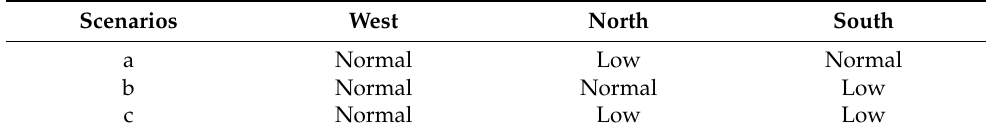
Figure 1. The divided three zones of IEEE 39 Bus New England power system. Here in the Figure, the Generator buses are presented with the red place-marks, PQ buses are with the blue place-marks, and the transmission lines are with yellow lines. Table 1. Assumed cases for the sensitivity